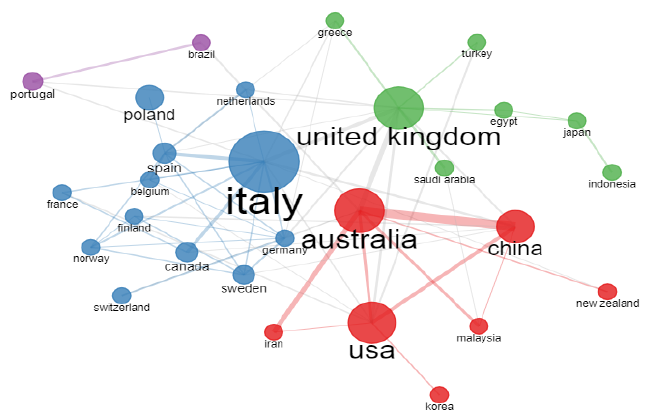
Figure 13. Collaboration network of countries/regions.